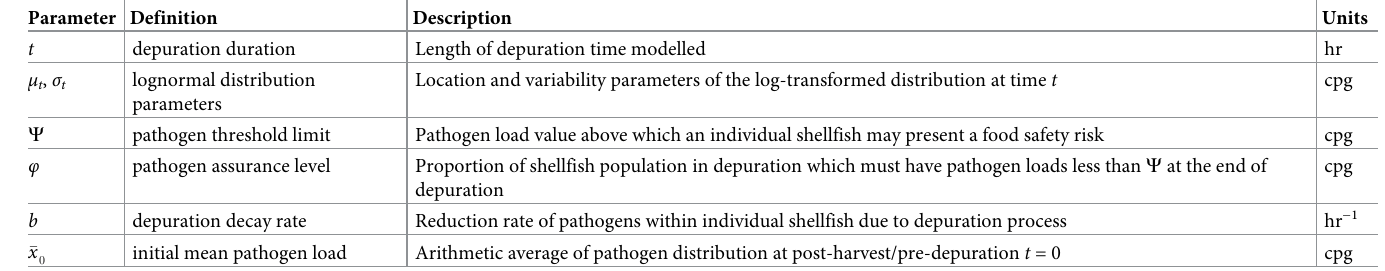
Table 1. Parameter